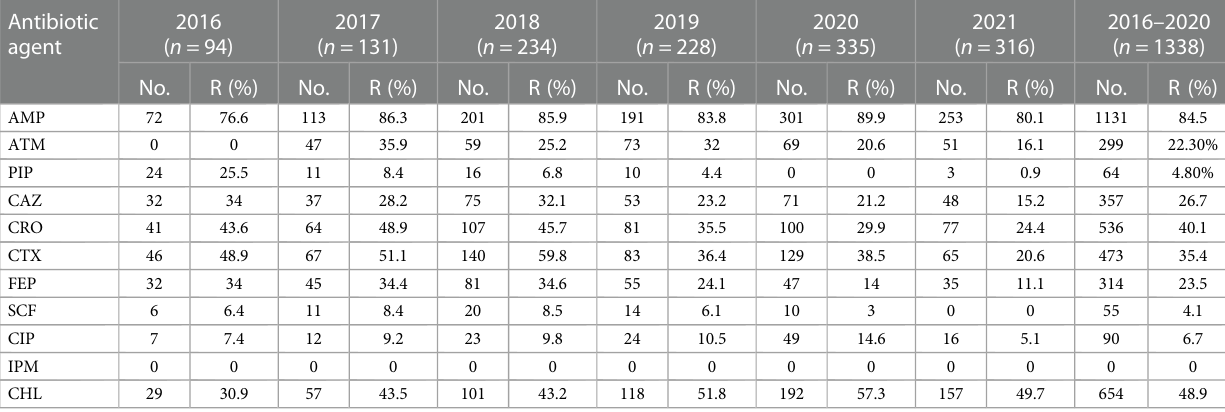
TABLE 3 Antimicrobial resistance rates of the 1,338 Salmonella strains. Antibiotic